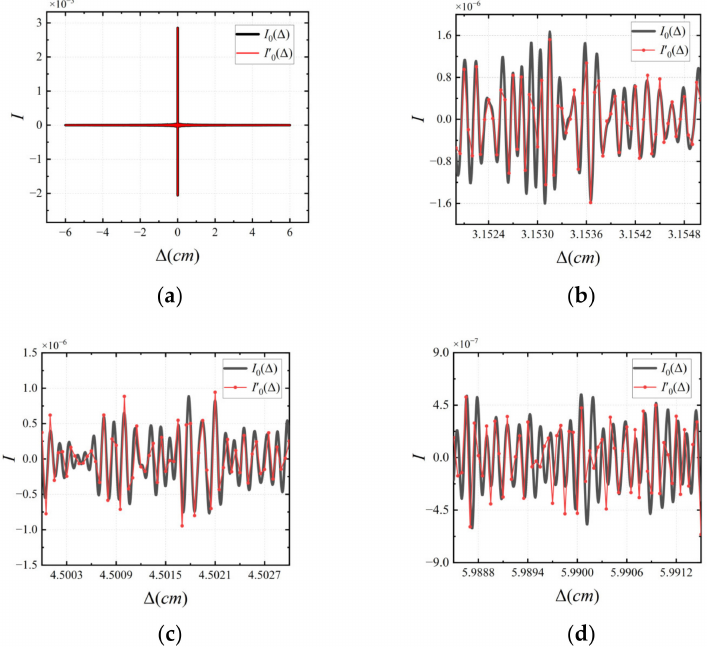
Figure 10. ( a ) The interferogram when the input spectrum is the spectral data; ( b – d ) the partial magnification comparison of this interferogram.